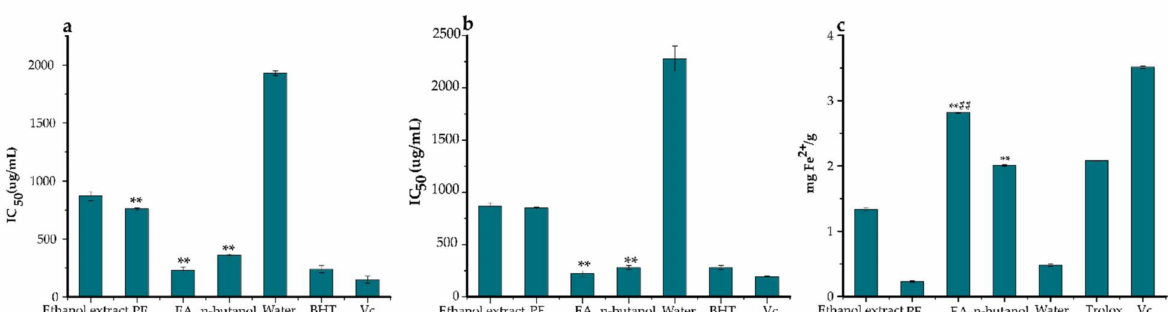
Figure 3. The antioxidant activities of ethanol extracts, petroleum ether (PE), ethyl acetate (EA), n -butanol, and water fractions of Ficus glumosa in IC 50 and mg Fe 2+ /g. ( a ) The IC 50 values of DPPH (2,2-diphenyl-1-picrylhydrazyl) assay, ( b ) ABTS (2,2 (cid:48) -azino-bis (3-ethylbenzothiazoline-6-sulfonic acid) assay, and ( c ) FRAP (ferric-ion reducing power) assay exhibited by ethanol extracts, PE, EA, n -butanol, and water fractions of Ficus glumosa , and positive controls; BHT (butylated hydroxytoluene), Vc (vitamin c). ** p < 0.05 and ## p < 0.05 as compared to ethanol extracts and Trolox,